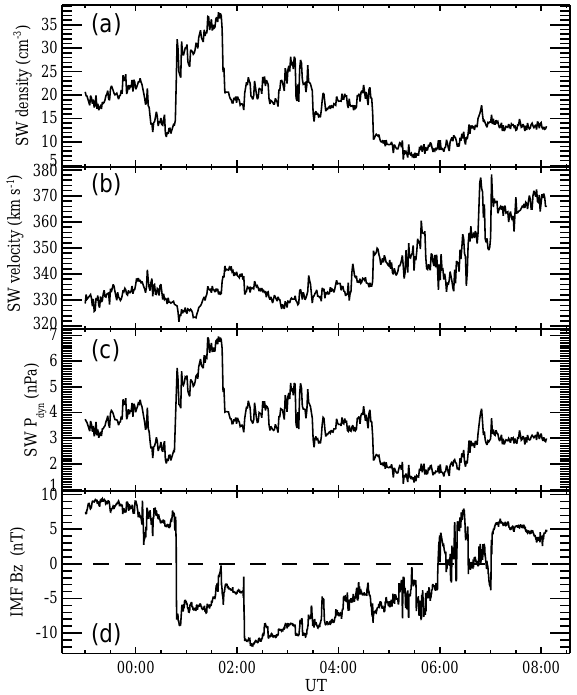
Figure 2. Solar wind properties recorded by the ACE (Advanced Composition Explorer) satellite on 2 and 3 January 2001. The timescale has been shifted by 79min to approximately account for the propagation time from the spacecraft to the Earth. The solar wind dynamic pressure in (c) is computed from the number density and the velocity shown in (a) and (b) . The IMF remained southward for ∼ 5h, as shown in (d) (GSM